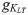
The effect of phasic dynamics are robust to noise statistics and linearly related to gKLT expression.(A—D) The effect of varying signal-to-noise ratios (SNR) on the outcome of the total entropy (A), noise entropy (B), MI (C), and selectivity (D) analyses. As the amplitude of the noise current increases relative to the amplitude of the stimulus-driven current (decreasing SNR), noise increases and MI and selectivity decrease, but phasic models continue to outperform tonic models. The red lines shows the means of phasic models, and the blue line shows the means of tonic models. Bars show standard error. The gray boxes indicate the parameter values used in this study. (E—H) The effect of noise shapes on total entropy (E), noise entropy (F), MI (G), and selectivity (H). Adding white noise erases the advantage of phasic neurons, but white noise is biologically unrealistic and ineffective at driving significant amounts of variability (F). More biologically realistic noise shapes with greater power at low frequencies, such as pink (1/f) and red (1/f2), produce comparable results when SNR is adjusted to match variability. Mean and standard error shown. White noise shown at SNR 0.5, pink noise at SNR 2, and red noise at SNR 4. (I–L) The effect of gKLT conductance on total entropy (I), noise entropy (J), MI (K), and selectivity (L) for the phasic models.